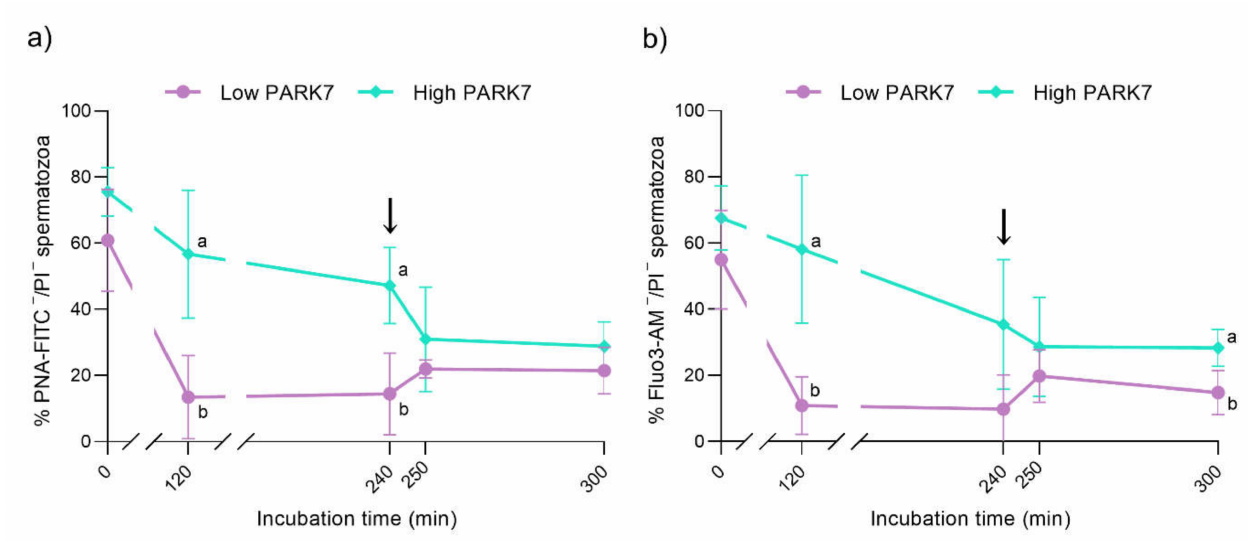
Figure 5. Percentages of viable sperm with an intact acrosome membrane (PNA − FITC-/PI − population) ( a ) and viable sperm with low intracellular calcium levels (Fluo3-/PI- population) ( b ) during in vitro capacitation and acrosomal exocytosis induced by progesterone (300 min). The black arrows indicate the addition of progesterone at a final concentration of 10 µ g/mL (240 min). Data are represented as means ± SD. Different letters indicate significant differences ( p < 0.05) between sperm samples containing high and low relative levels of